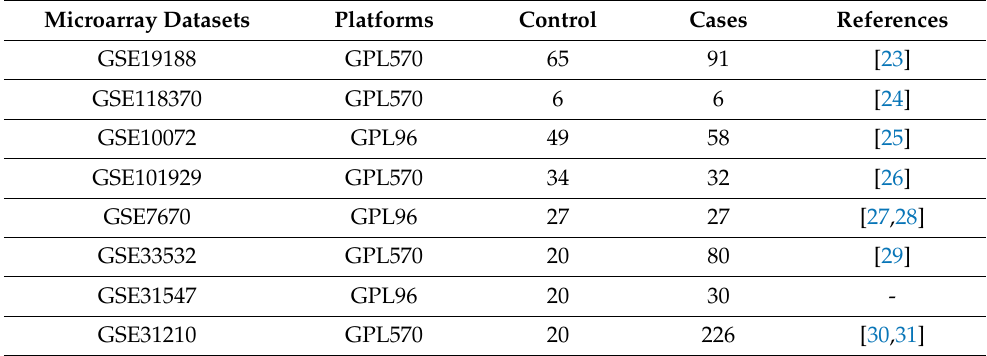
Table 1. List of datasets used in the